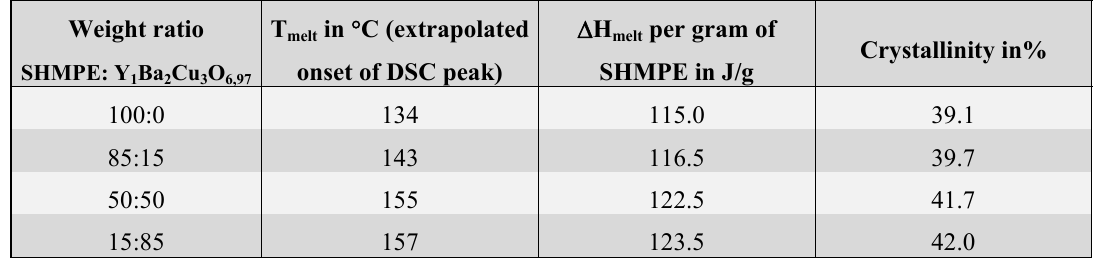
Table 8. Influence of the filling rate on the temperature and enthalpy of melting of